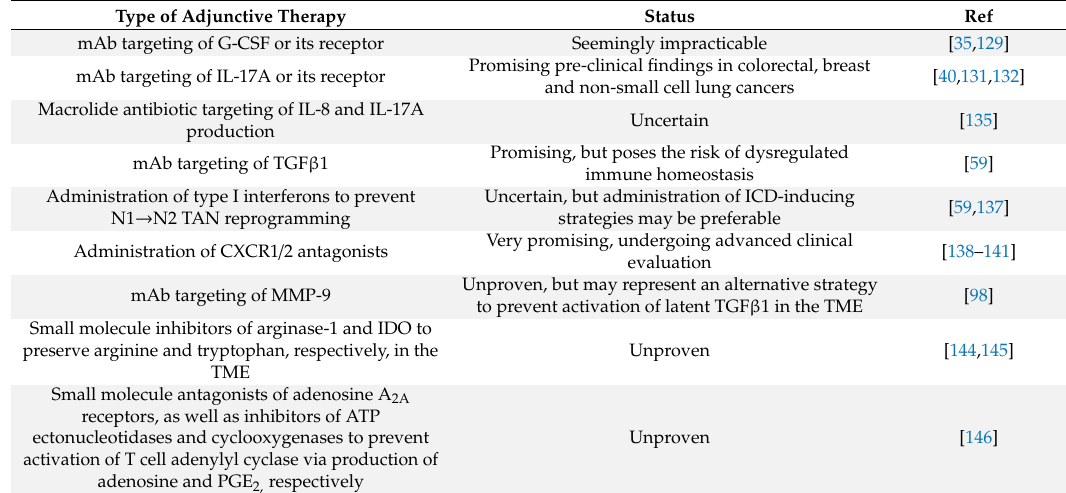
Table 4. Potential MDSC-targeted adjunctive therapies of advanced